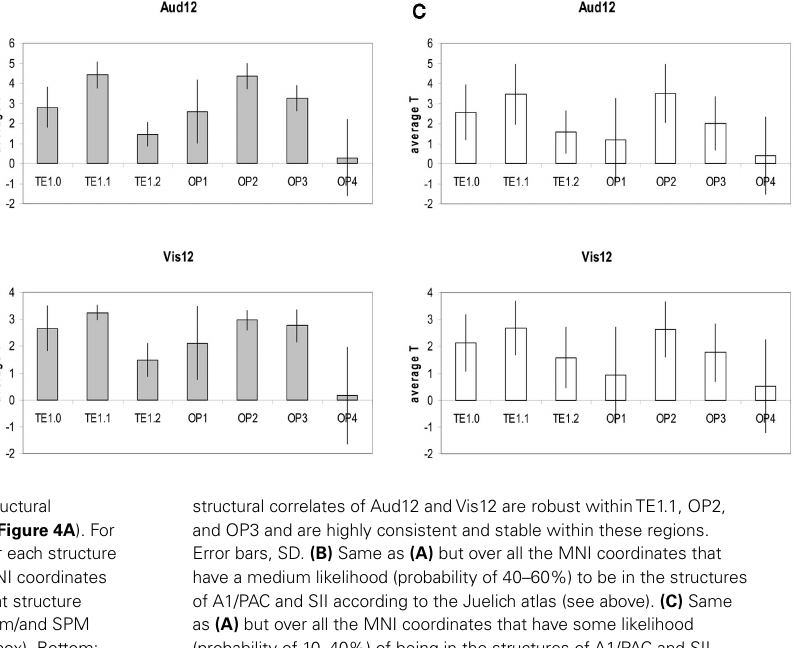
FIGURE 5 | (A) Top: average T statistics of the Aud12 structural correlates t -map (as seen in Figure 3 bottom left and in Figure 4A ). For each structure of A1/PAC (i.e.,TE1.0,TE1.1,TE1.2) and for each structure of SII (i.e., OP1–OP4) the average is done over all the MNI coordinates that are highly likely (probability of 60–100%) to be in that structure according to the Juelich atlas (http://www.fz-juelich.de/inm/and SPM toolbox http://www.fz-juelich.de/ime/spm_anatomy_toolbox). Bottom: same analysis for theVis12 structural correlates.The data show that the